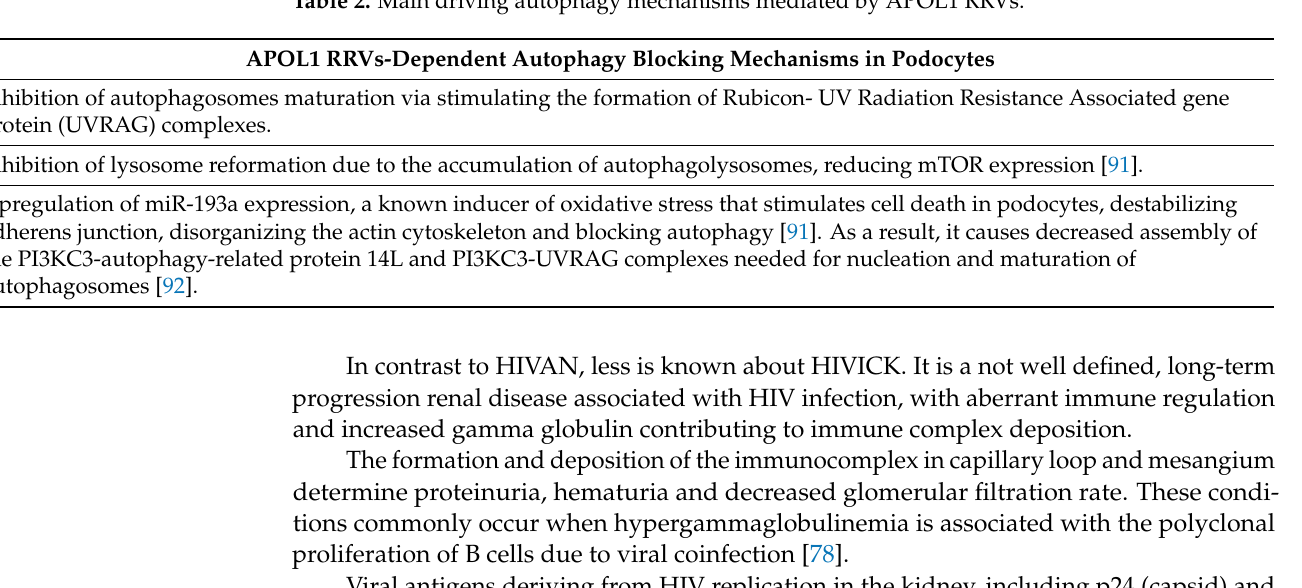
Table 2. Main driving autophagy mechanisms mediated by APOL1